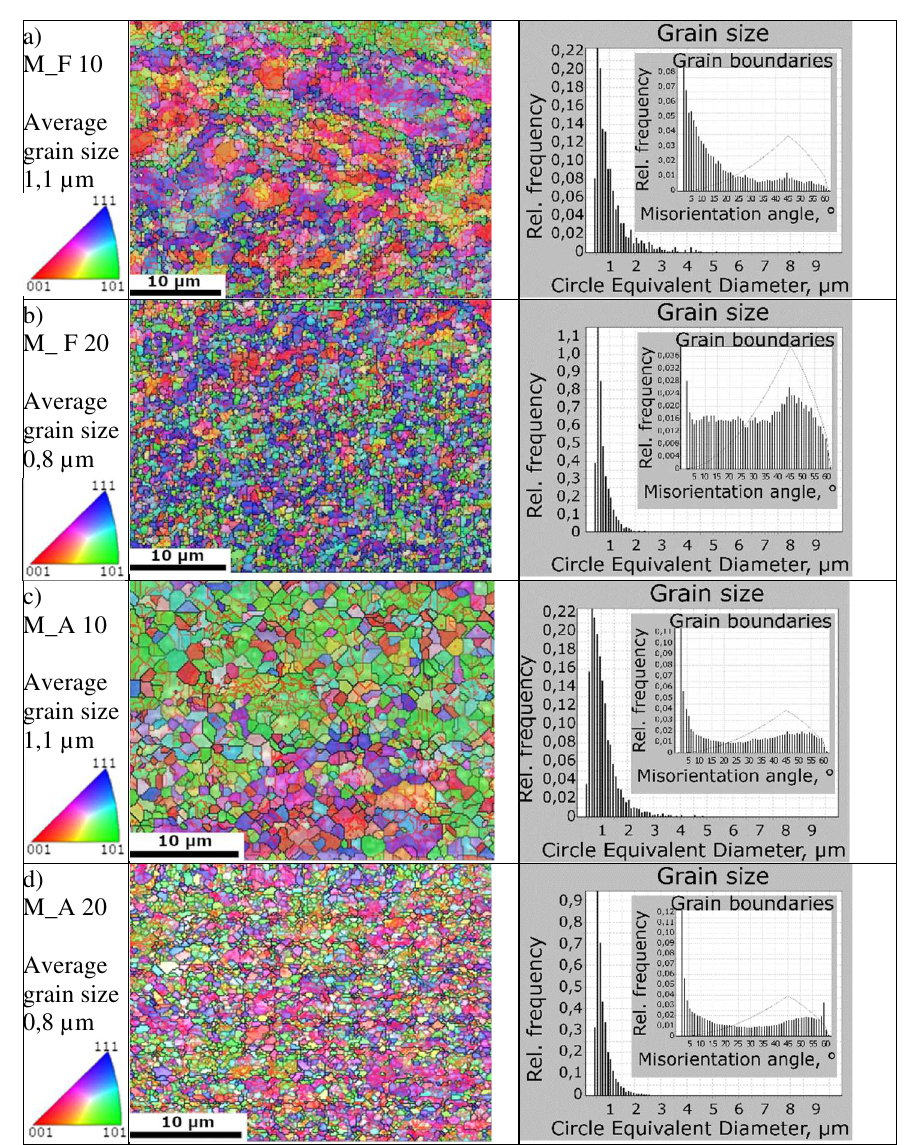
Fig. 1. Results of microstructural analysis of the samples produced by the MaxStrain system. Second column – IPF maps with marked high-angle (black) and low-angle (red) boundaries. Third column – histograms of boundaries misrientation angle and grain size